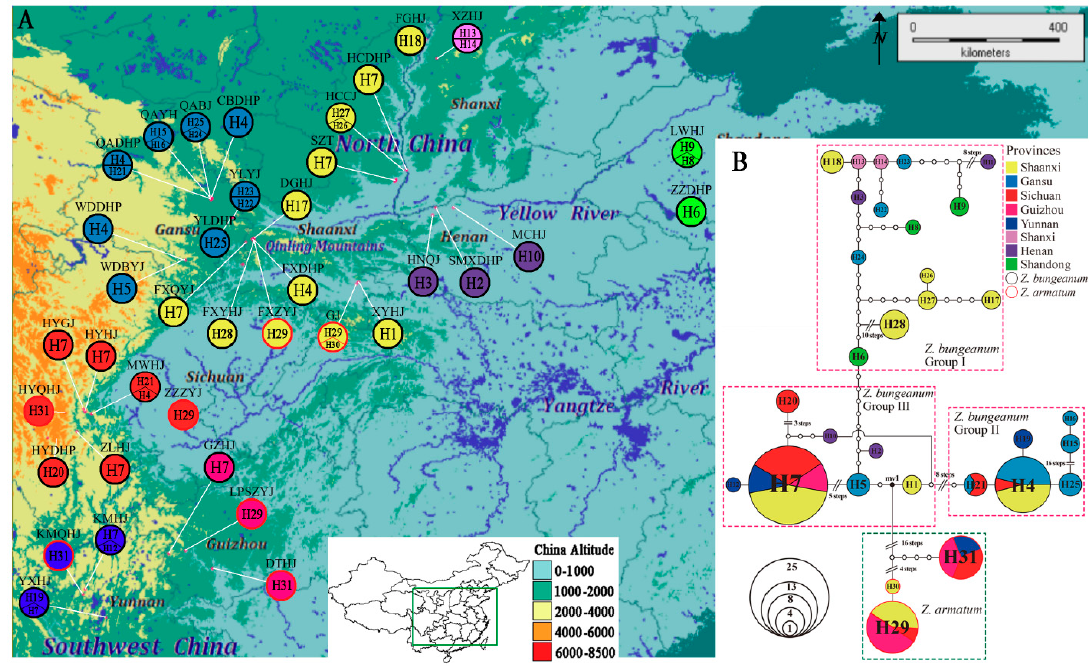
Figure 2. ( A ) Locality of Chinese pepper cultivars / populations collected from eight provinces. ( B ) TCS-derived network of 31 haplotypes detected in this study. The size of circles corresponds to the frequency of each haplotype. The eight provinces were presented by di ff erent colors. A small open circle linking the haplotypes represents a single